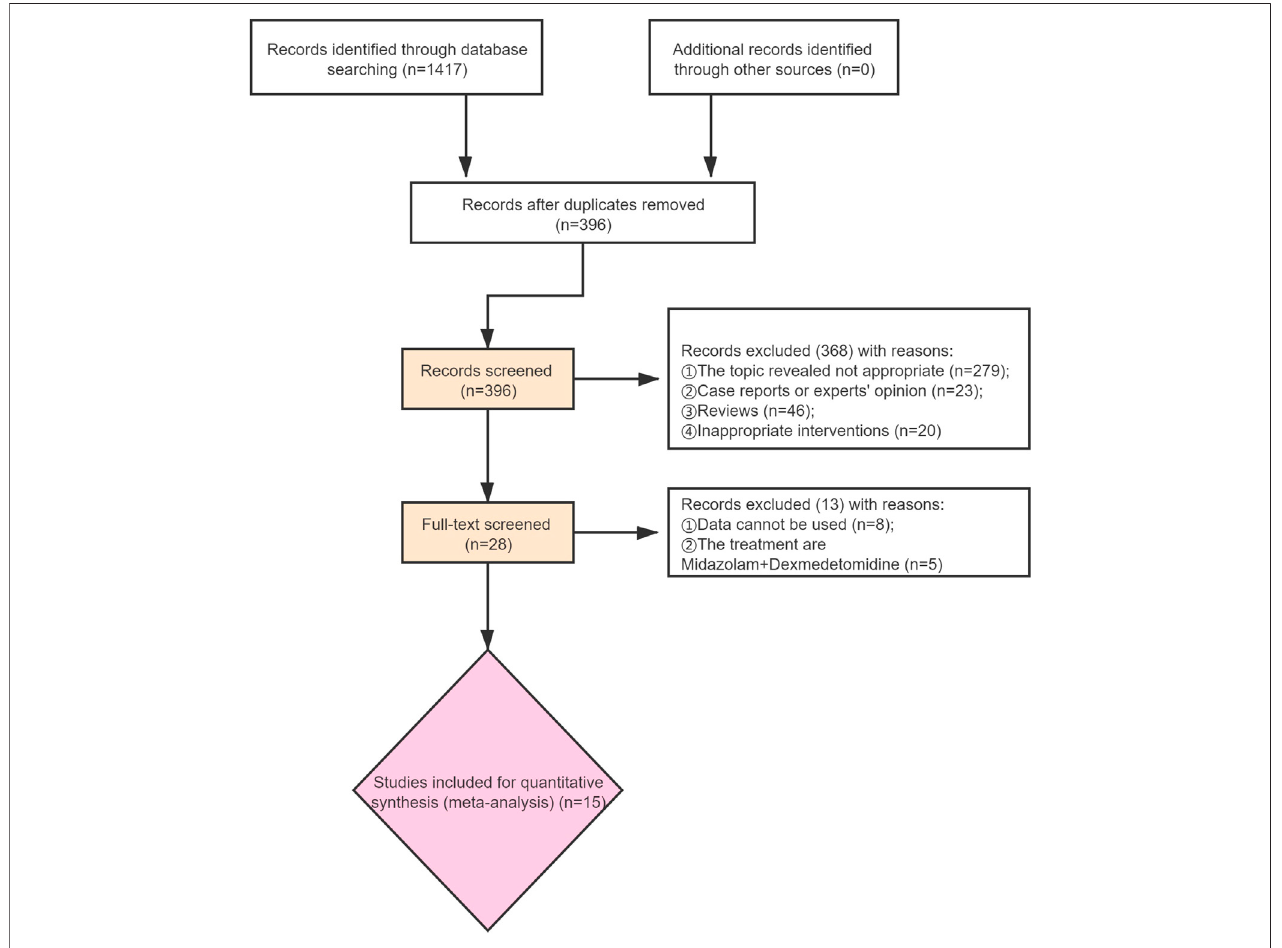
FIGURE 1 | Flow chart of included studies